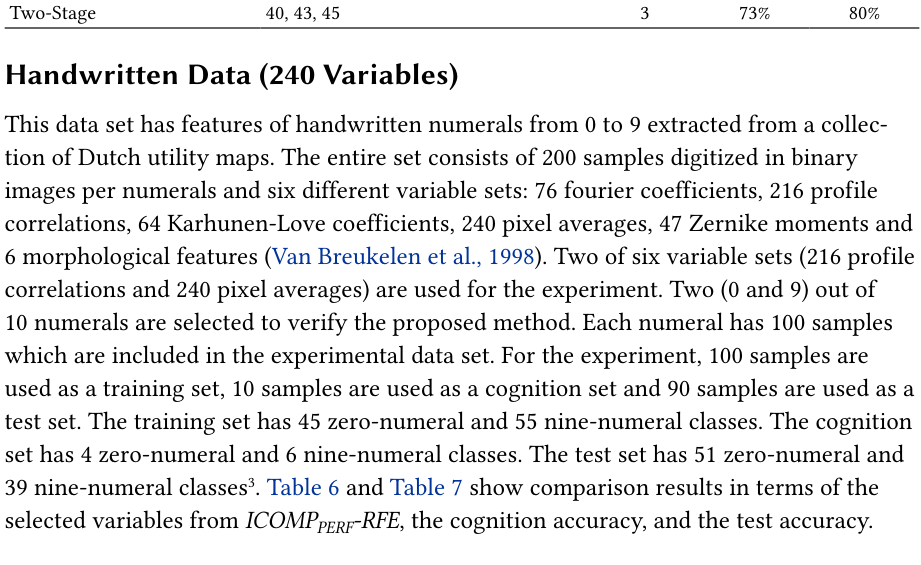
PDCM Versus Various Ranking Based Method Using Cauchy Kernel